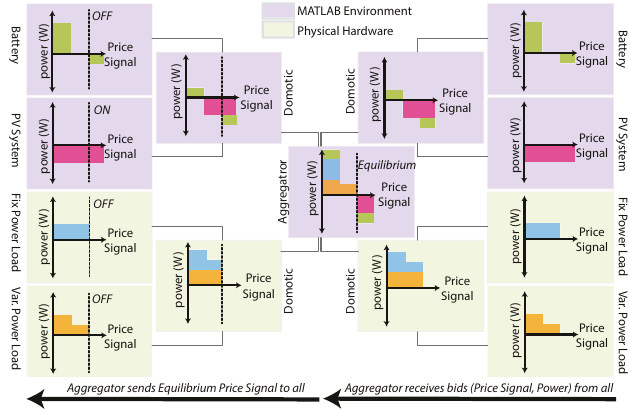
Fig. 5. Three layer multi-agent system for Transactive based control mecha- nism . On the other hand, domotic agents exist in the middle layer of the organization. Herein, domotic agent worked as a transceiver of bid and price signal between the connected appliance agents and the aggregators. In this architectural design, appliance agent were representatives of real physical load (like battery,